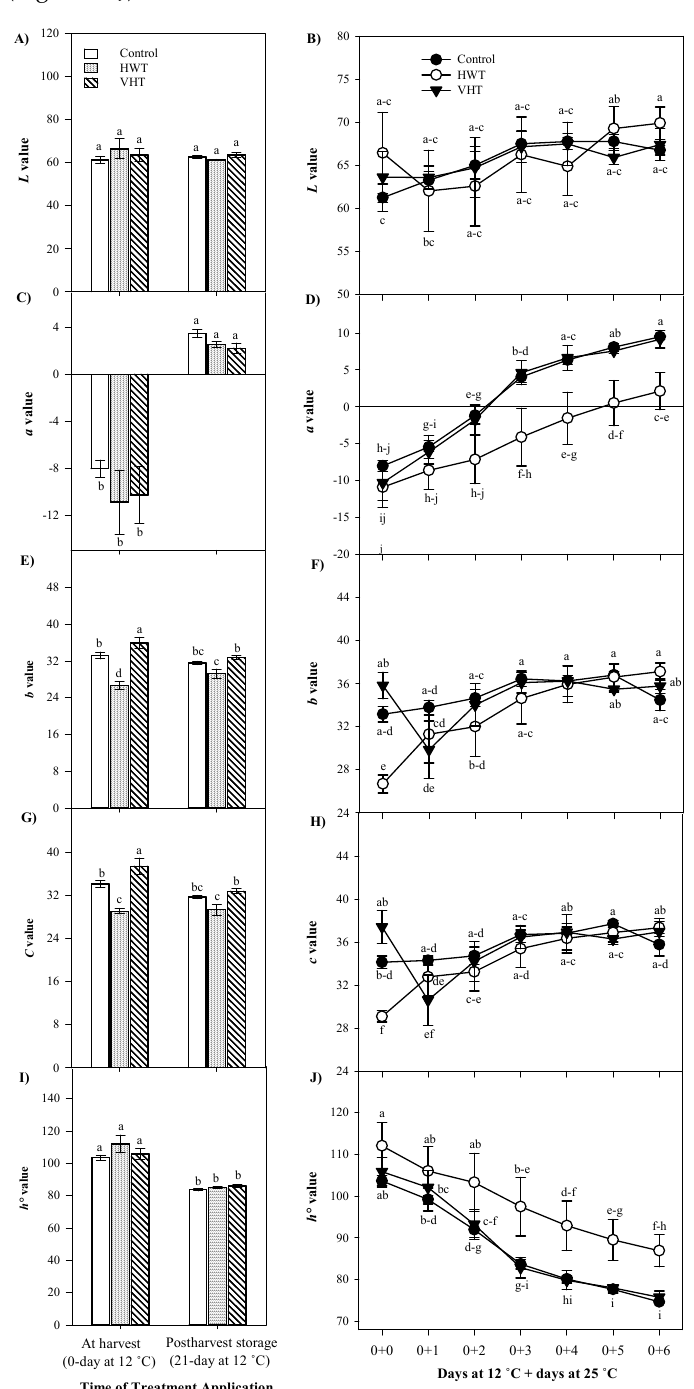
Figure 4. Effect of the heat treatments applied at harvest and post-harvest storage on the L value ( A , B ), a value ( C , D ), b value ( E , F ), and C value ( G , H ) and h° value ( I , J ) of mango fruits. Error bars show standard errors of the means ( n = 3). Different letters indicate significant difference according to LSD at p ≤